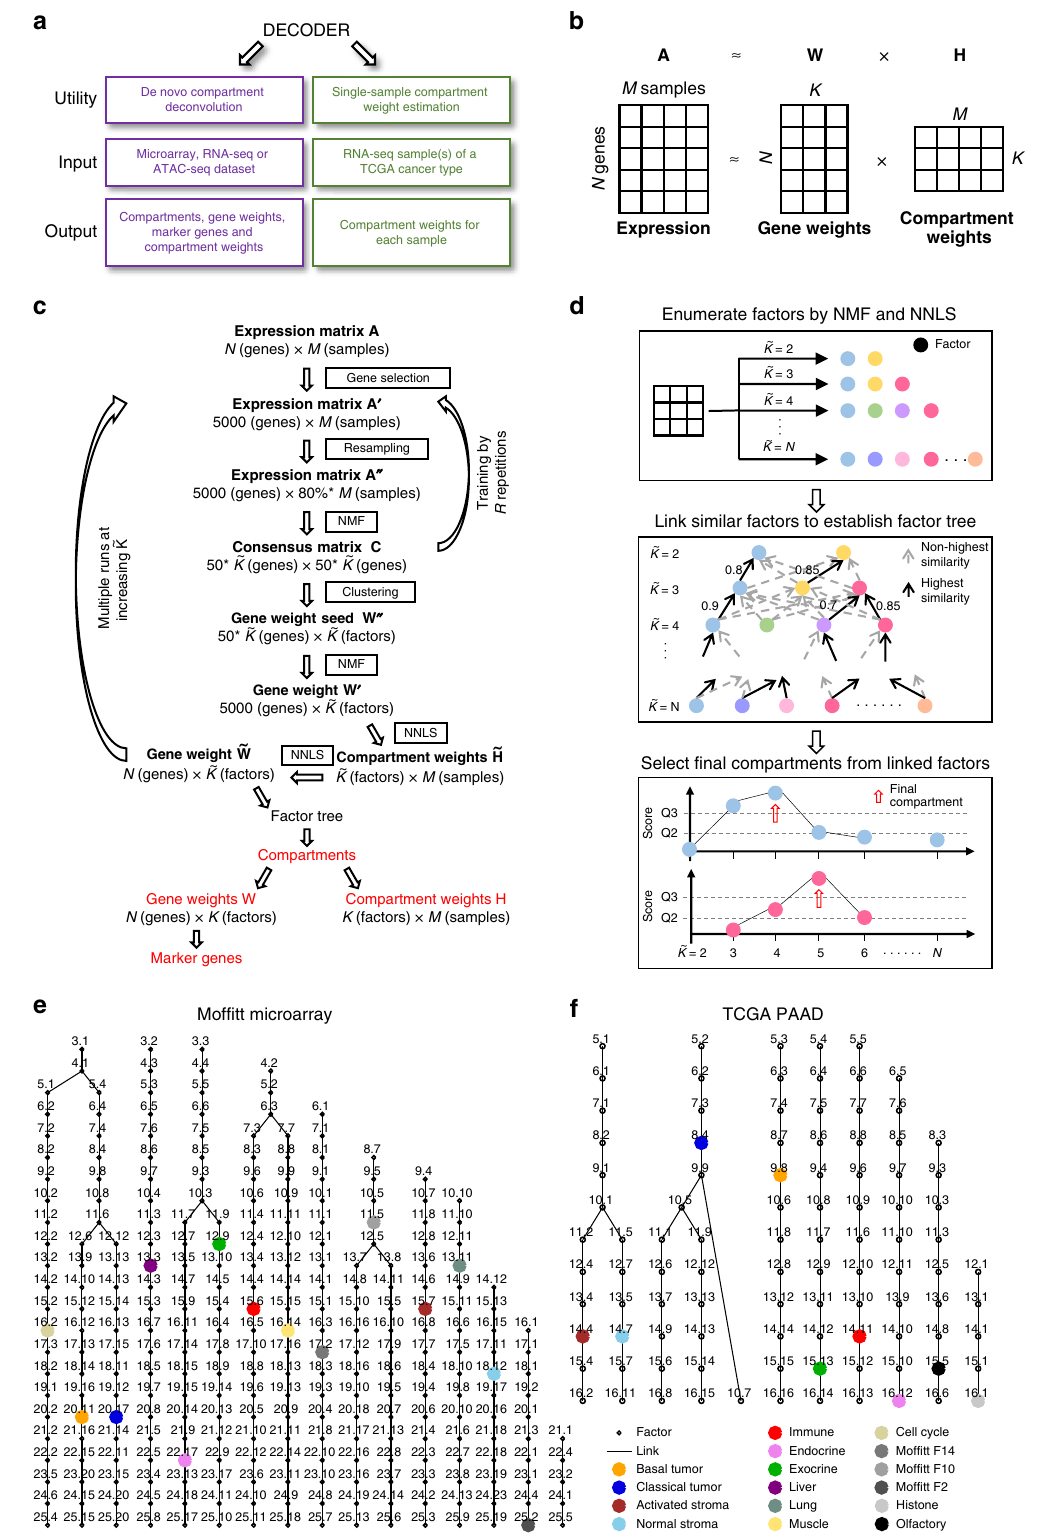
Fig. 1 Overview of DECODER and the application of it. a The utility of DECODER includes de novo compartment deconvolution for a data set, and single- sample compartment weight estimation for TCGA cancers. b De novo deconvolution of DECODER aims to factorize an expression matrix A into two matrices of W (gene weights for compartments or gene weights) and H (compartment weights for samples or compartment weights). c The main steps for de novo deconvolution of DECODER. d The identi fi cation of fi nal compartments from factors in multiple runs of ~ K . e , f The factor trees for the Mof fi tt microarray data set and the TCGA PAAD data set, respectively. The resultant major compartments are colored, with the dropped factors, minor and unstable compartments denoted by black circles. Factor ID is used for